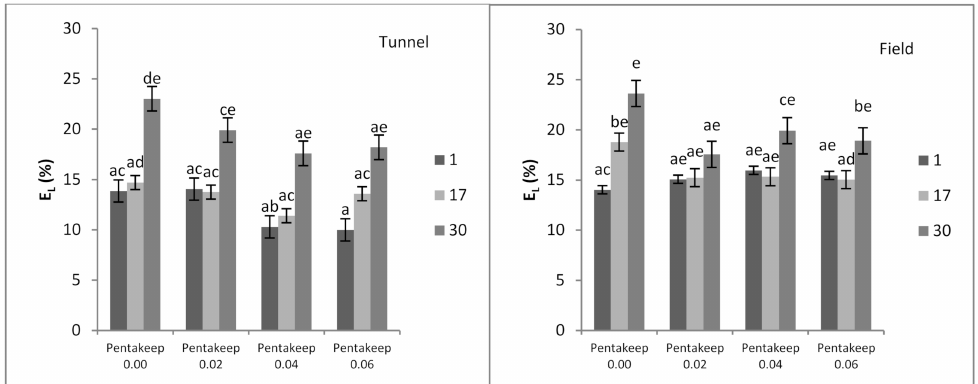
Figure 1. E ff ect of growth conditions (unheated foil tunnel and open field) and foliar treatment (six times during vegetative period) with di ff erent concentrations of Pentakeep V (0.00%, 0.02%, 0.04%, 0.06%) on the value of electrolyte leakage (E L ) from leaf cells measured after 1, 17, and 30 days of storage of the P. multiflorum cut foliage in water. Values are mean ± SE, n = 5. The bars marked with the same letters are not significantly di ff erent at p <